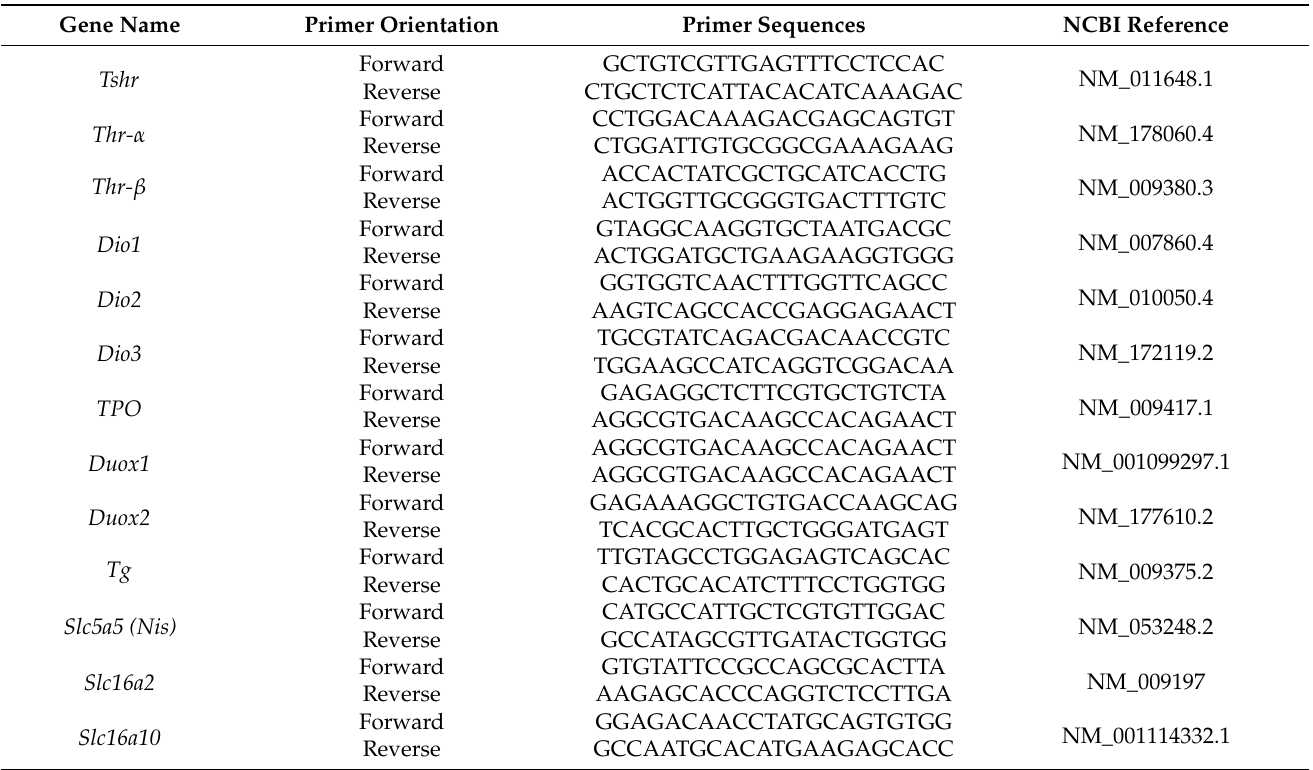
Table 1. Primers used for quantitative real-time